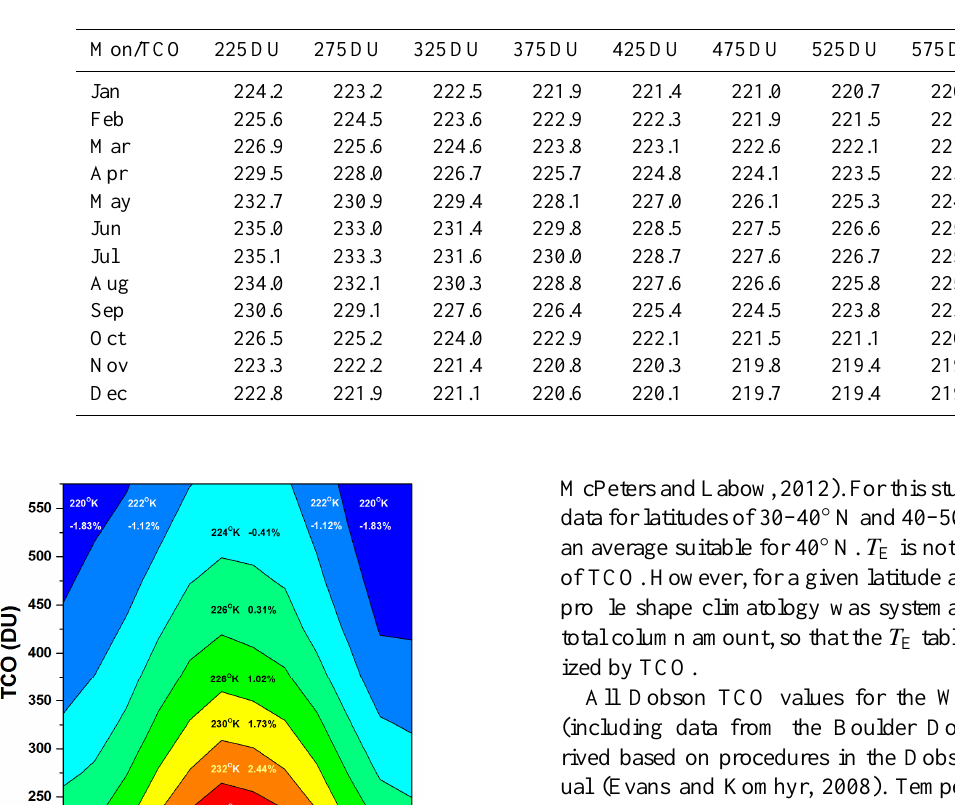
Table 1. Ozone weighted average effective temperature T E ( ◦ K) vs. ozone amount (DU) and month appropriate for Boulder, Colorado.